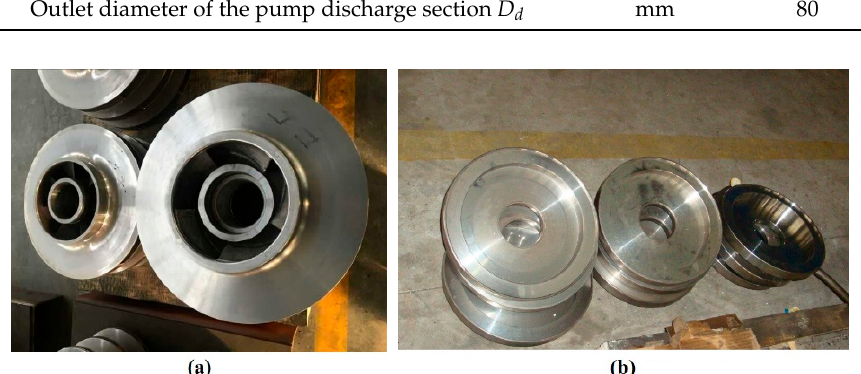
Figure 2. The main flow passage components including ( a ) the impeller and ( b ) the guide vane. Table 1. Main structure parameters.